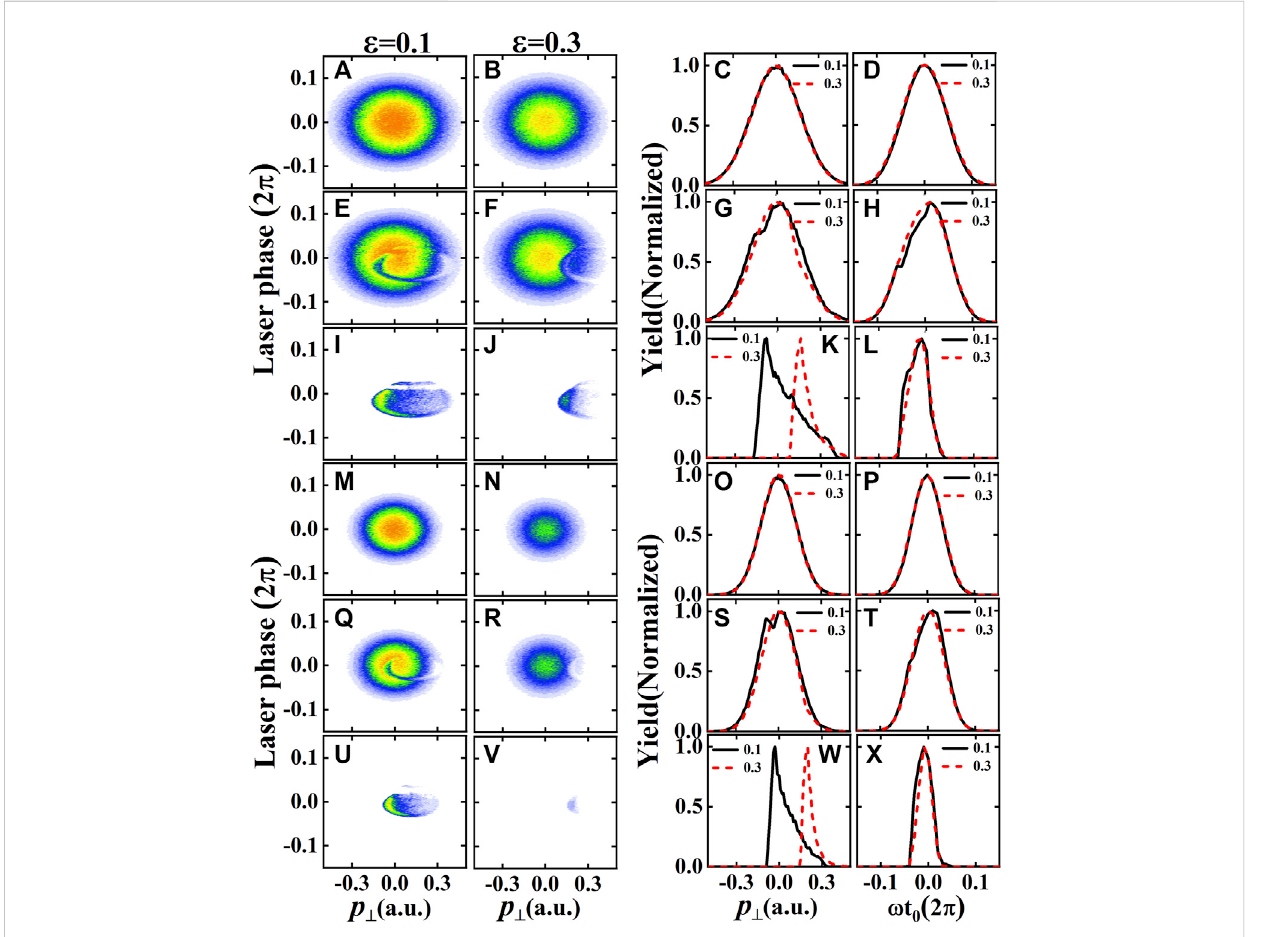
FIGURE 3 Thelaserphasedependenceoftheinitialphotoelectrontransversemomentumdistributionsfortunneling (A,B,M,N) ,ionization (E,F,Q,R) andRSE (I,J,U,V) processes attheellipticitiesof ε =0.1 (A,E,I,M,Q,U) , ε =0.3 (B,F,J,N,R,V) .Theinitialphotoelectrontransversemomentumdistributionsin (C, G, K, O, S, W) and laser phase distributions in (D, H, L, P, T, X) are extracted from the data of (A, B , E, F, I, J , M, N , Q, R, U, V ), respectively. The laser intensities are 1.6×10 14 W/cm 2 (A – L) and 0.4×10 14 W/cm 2 (M – X) . The laser wavelengthes are 800 nm (A – L) and 1,600 nm (M – X) . These data are calculated by the CTMC